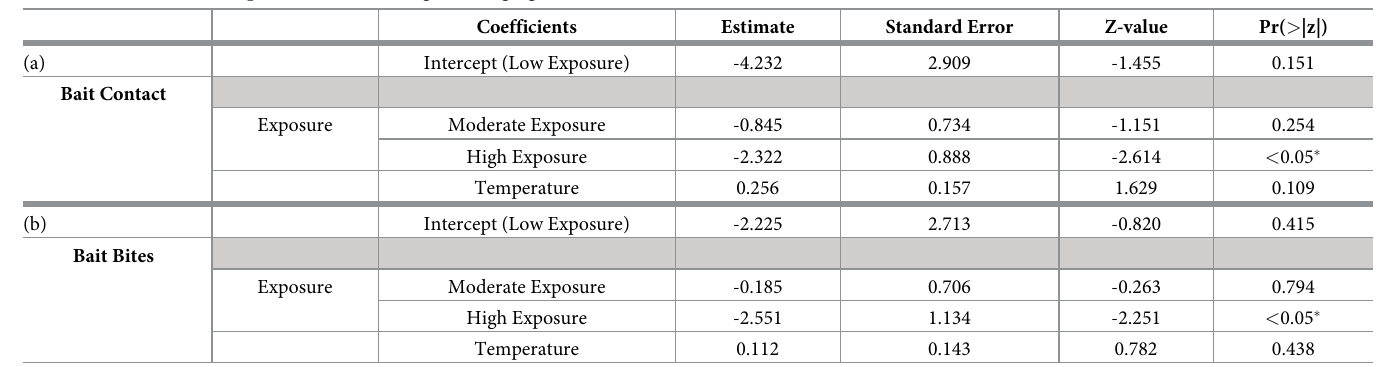
Table 3. Effects of shark exposure on smooth dogfish foraging behaviors.